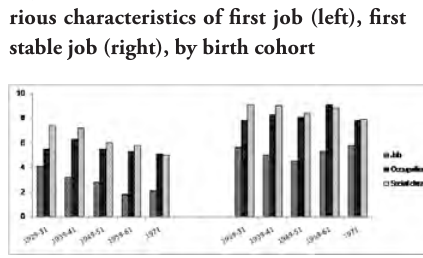
Figure 2: Median durations (years) of va- rious characteristics of first job (left), first stable job (right), by birth cohort